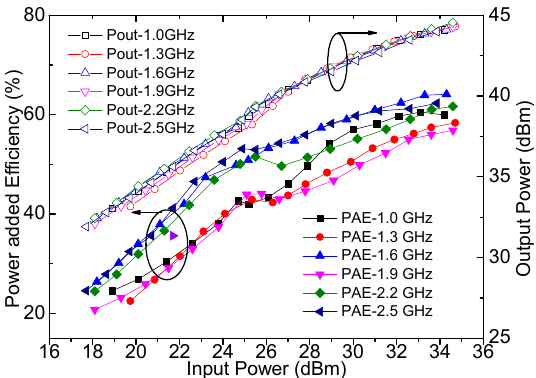
Figure 19. Measured drain efficiency and gain versus output power.